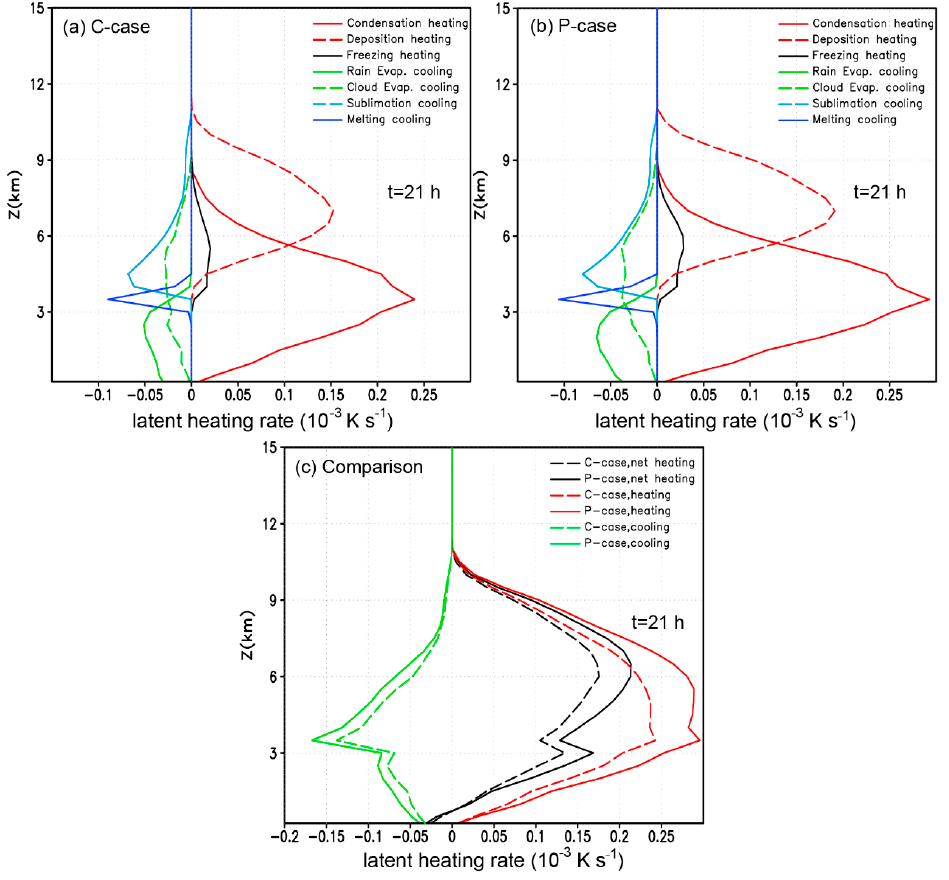
Figure 10. Same as Figure 9, but for t = 21 h.